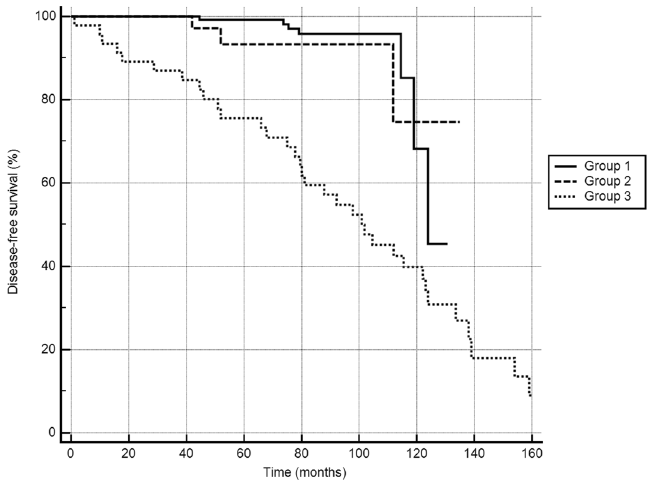
Figure 1. Disease-free survival in the three groups (p < 0.01), MedCalc Statistical Software version 19.1.7 (MedCalc Software Ltd, Ostend, Belgium; https:// www. medca lc. org; 2020).